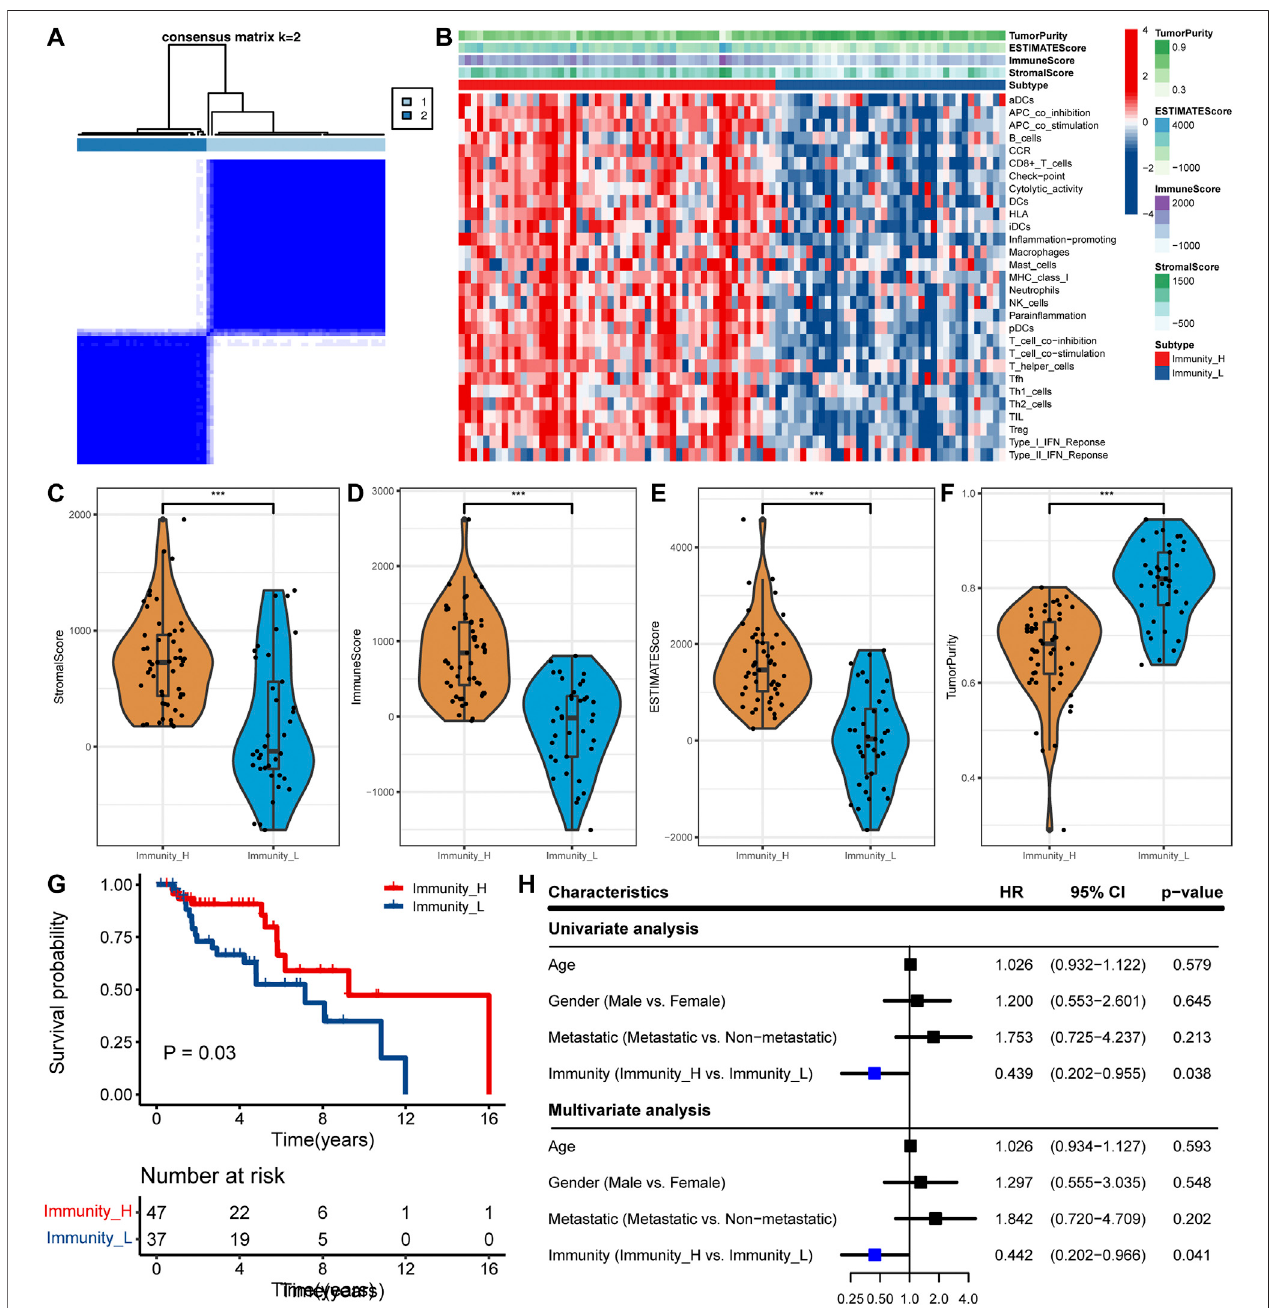
FIGURE 1 | Determine the two subtypes and prognostic analysis. (A) The heat map showing samples clustering results, with consensus k identi fi ed as 2. (B) The heat map showing the immune landscape of the two subtypes. (C – F) Comparison of (C) stromal score, (D) immune score, (E) ESTIMATE score, and (F) tumor purity between the two subtypes in the TCGA cohort ( ppp , p < 0.001). (G) Comparison of survival prognosis between OS subtypes. (H) Univariate and multivariate Cox regression analysis.